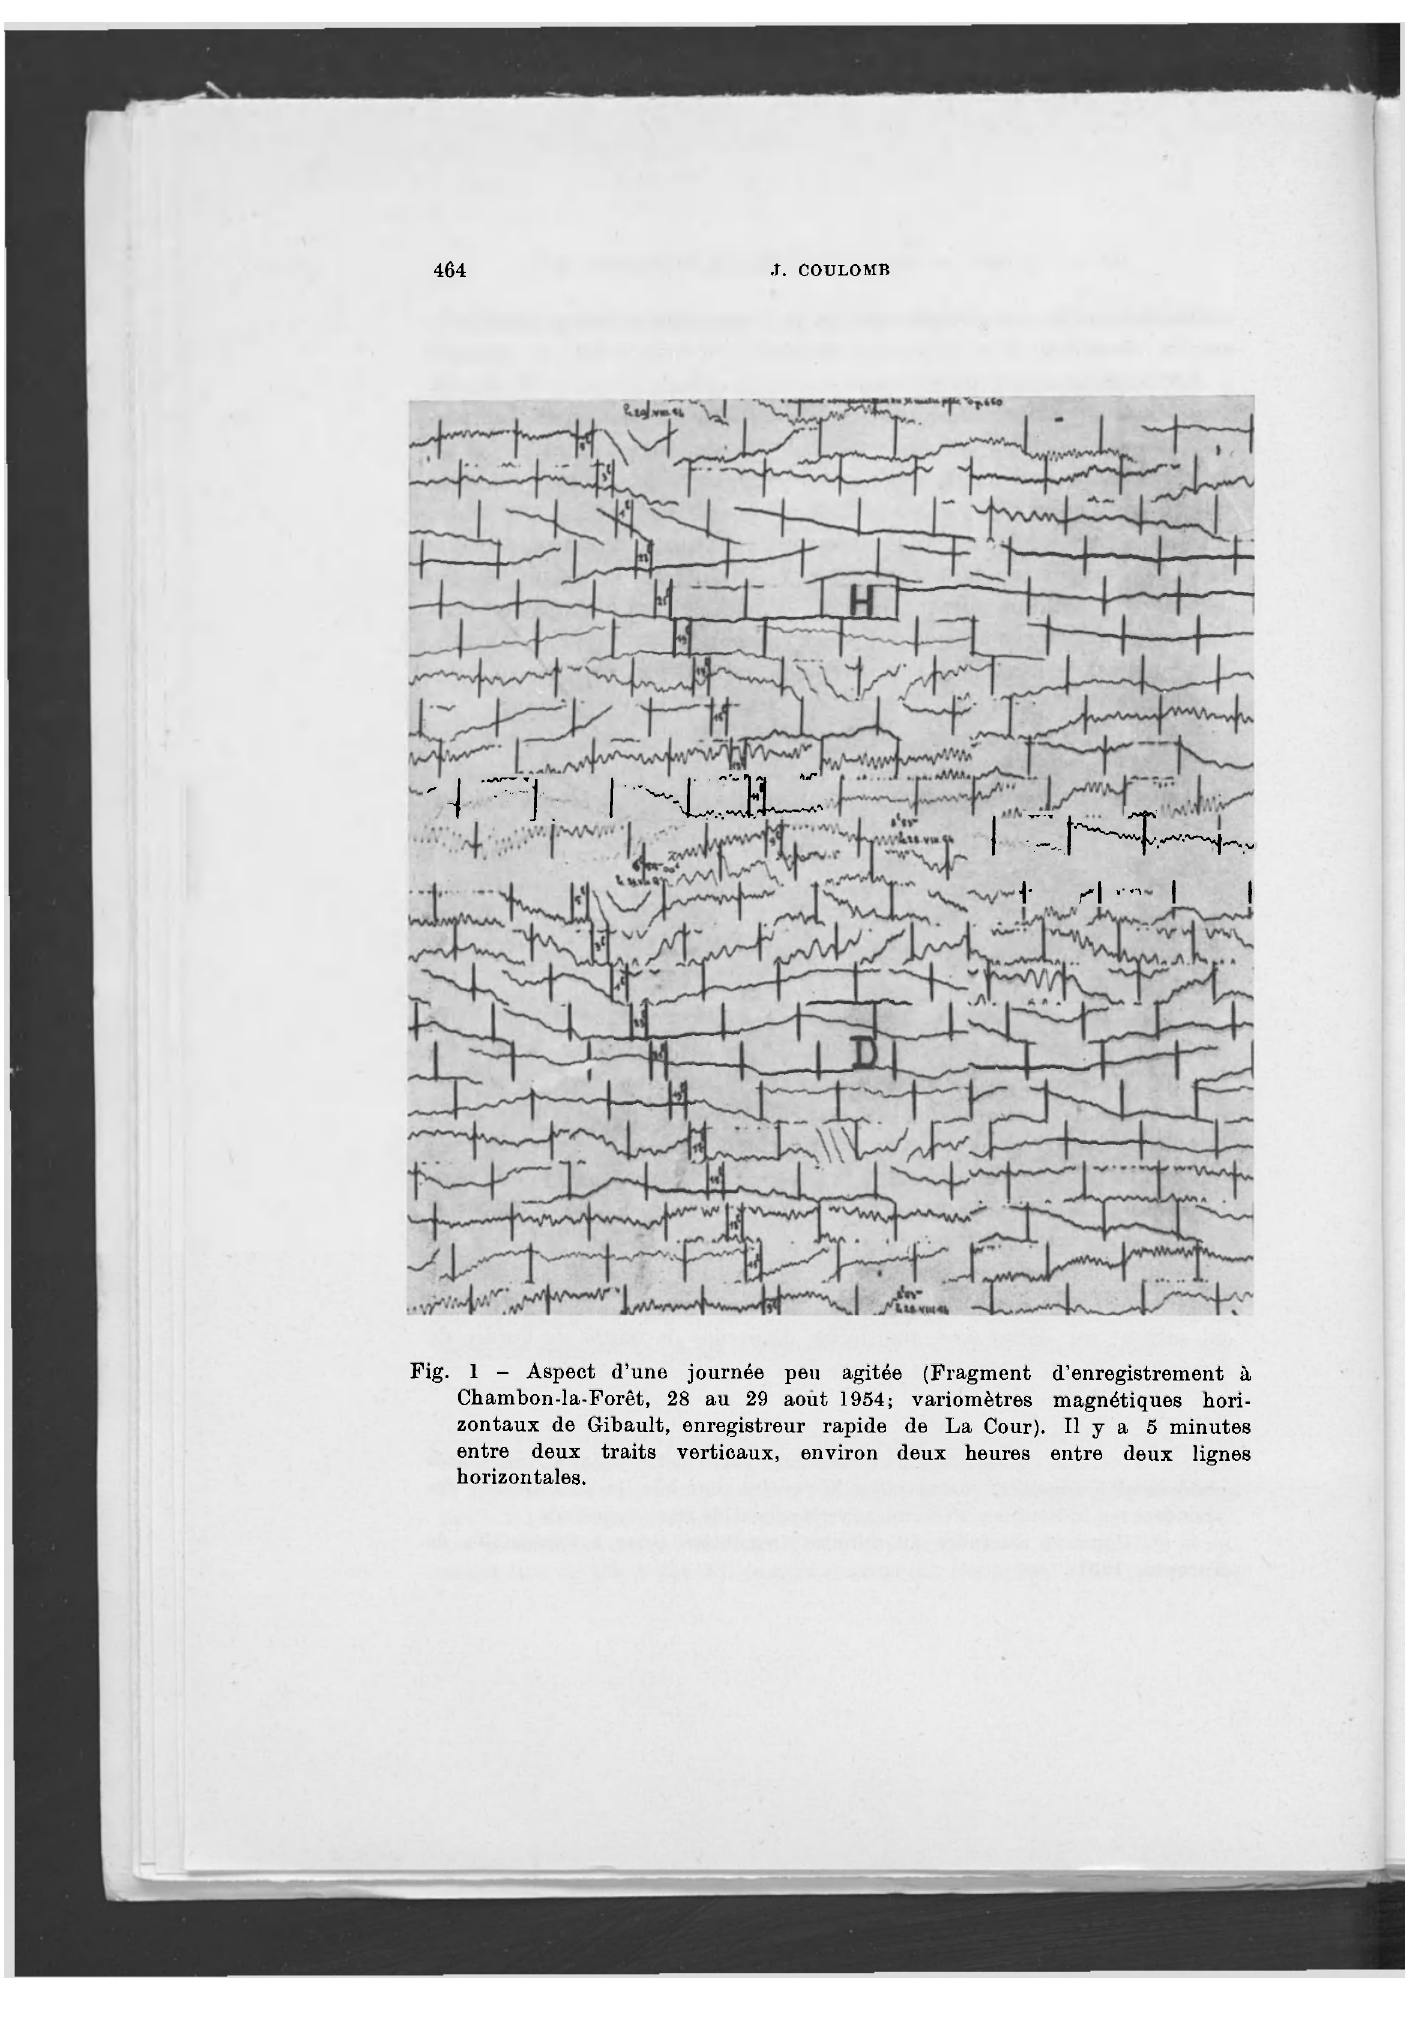
Fig. 1 - Aspect d'une journée peu agitée (Fragment d'enregistrement à Chambon-la-Forèt, 28 au 29 aout 1954; variomètres magnétiques hori- zontaux de Gibault, enregistreur rapide de La Cour). Il j a 5 minutes entre deux traits verticaux, environ deux he urea entre deux lignes